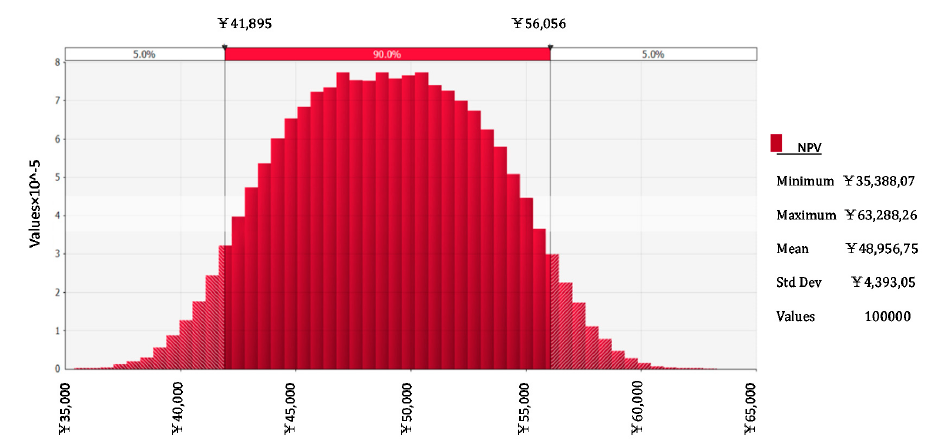
Figure 7. Comprehensive impact of changes in investment and operating costs on NPV.